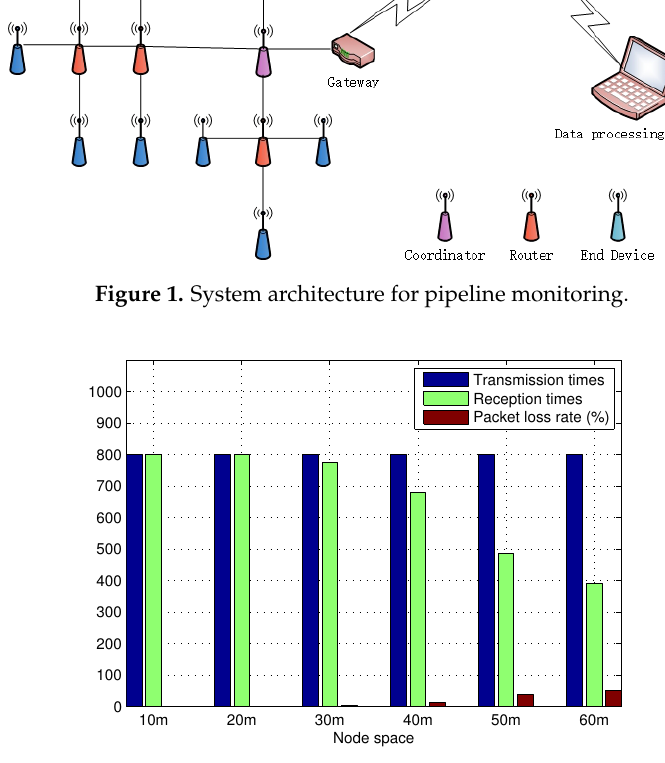
Figure 2. CC2530 packet loss rate under NLOS